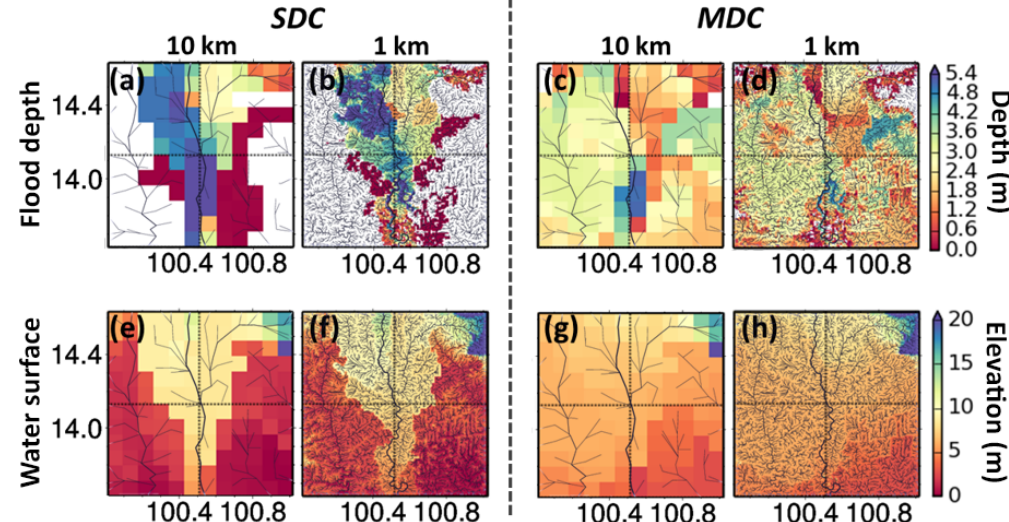
Figure 7. Impacts of spatial resolution and representation of MDC on simulated flood depth and water surface. (a–d) Flood depth and (e– h) water surface at the lower part of the basin. The first two columns show the results for SDC simulations at 10 and 1km resolutions while the last two columns show the results for MDC